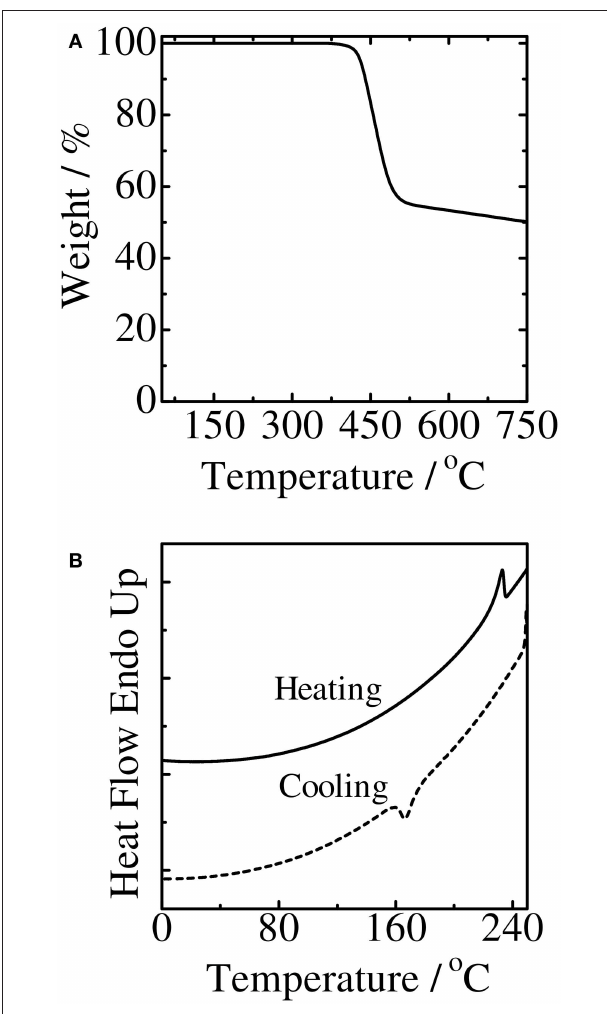
FIGURE 2 | Thermogravimetric analysis (A) and differential scanning calorimeter (B) curves of the polymers.